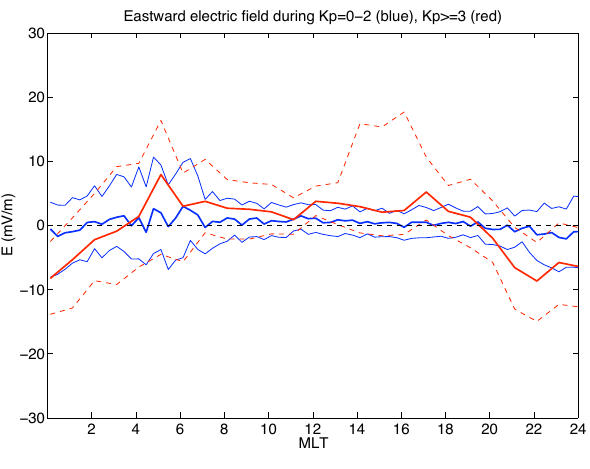
Fig. 12. Joule heating rate, same format as Fig.